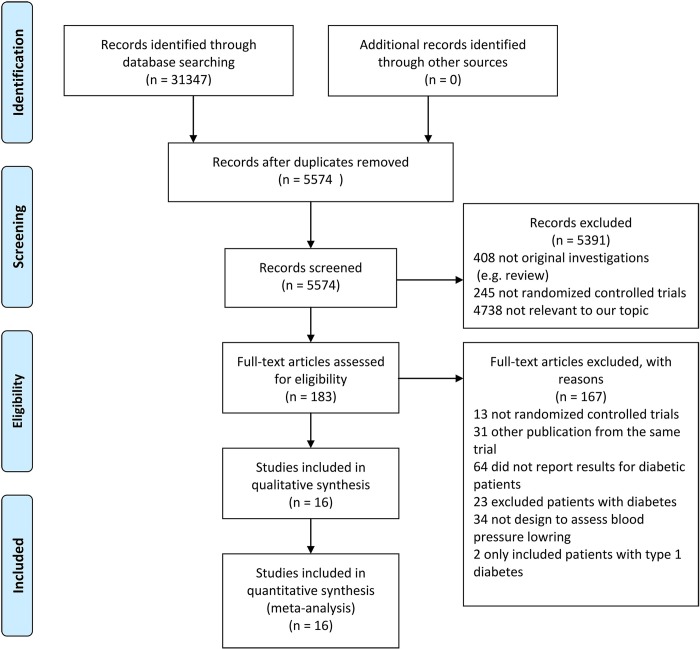
Flowchart of trial identification for meta-analysis.